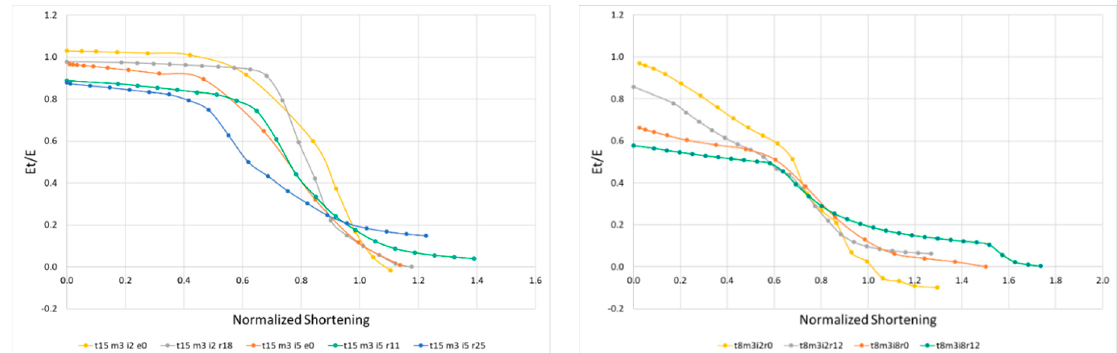
Figure 15. Variation of tangent modulus for intermediate ( left ) and very slender plates ( right ).